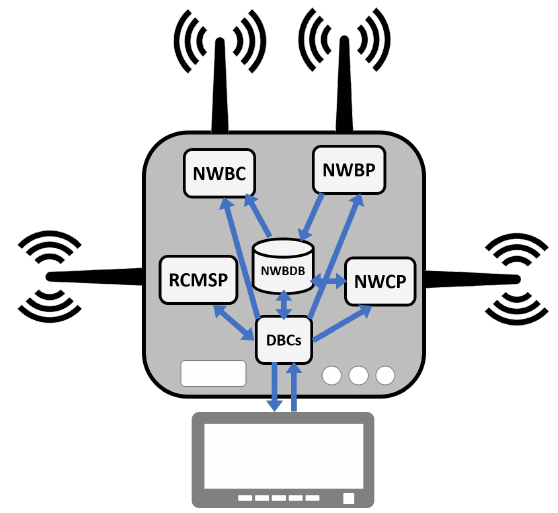
Figure 2. Interaction scenario between NOVA-WiFi-Beacons, NOVA-WiFi-Clients, and a remote control and monitoring system.